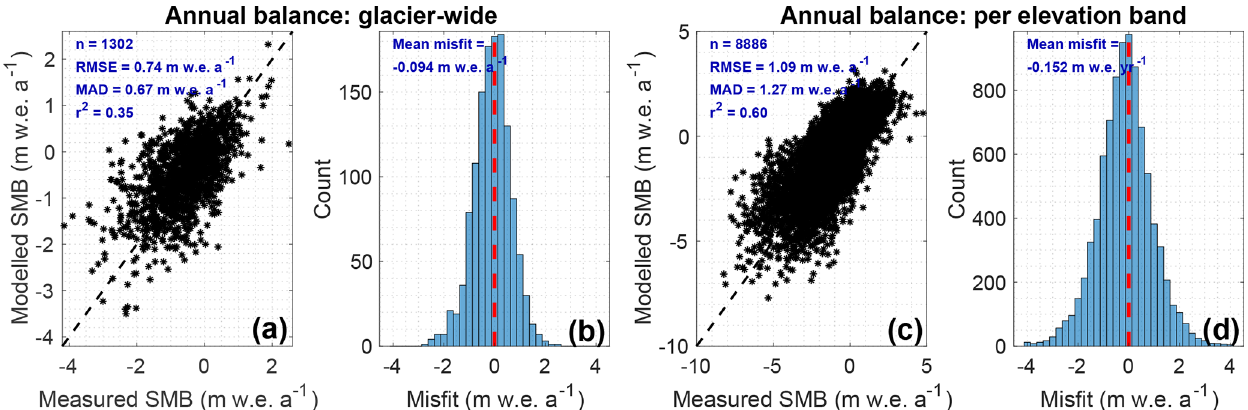
Figure 4. Evaluation of modelled SMB against observations from the WGMS (2018) database. All observations are included, except those that do temporally overlap with the geodetic mass balance observations (used for calibration). Scatterplots (a, c) and frequency of mis- fits (b, d) of modelled vs. measured glacier-wide annual balances (a, b) and annual mass balances per elevation band (c, d) . Dashed red lines in (b) and (d) represent the zero misfit. In (a) and (c) , n corresponds to the number of observations, RMSE is the root-mean-square error, MAD is the median absolute deviation and r 2 is the coefficient of